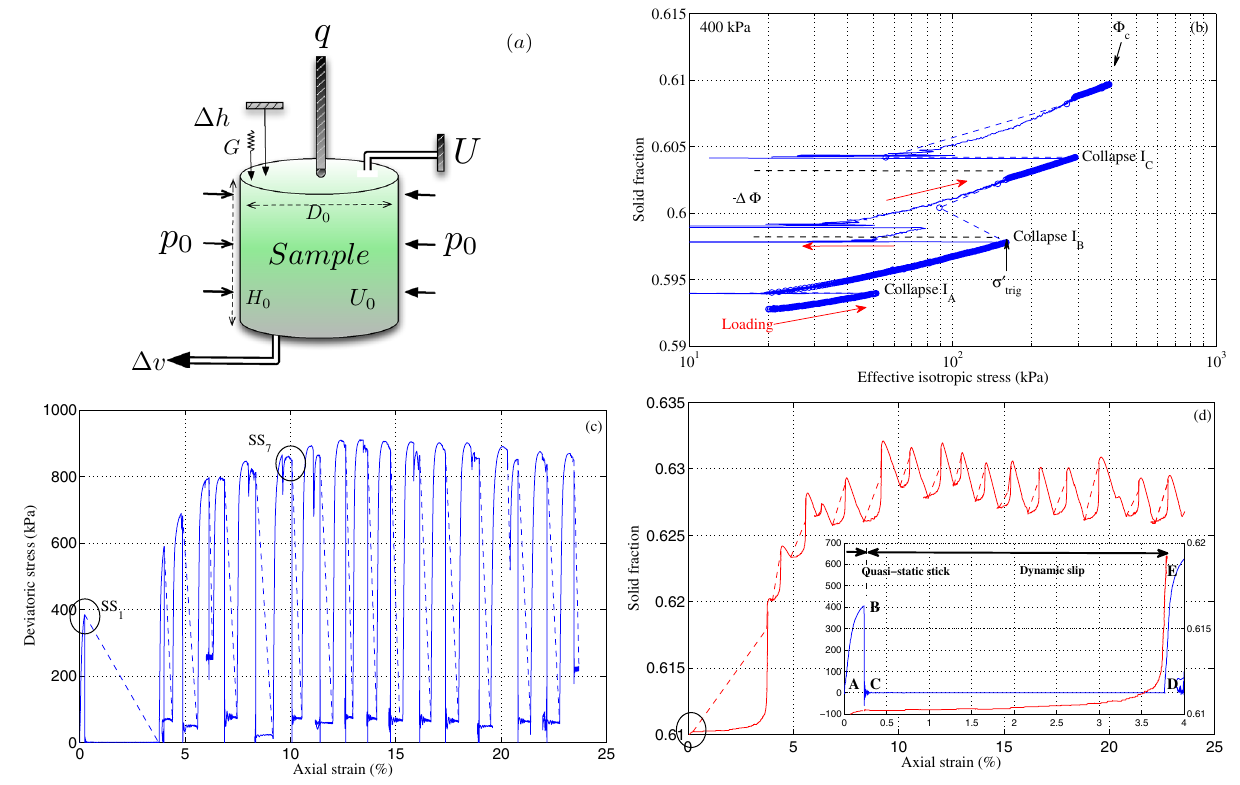
Figure 1. Dynamic instabilities of model granular materials in triaxial compression. ( a ) Sketch of the experimental setup of drained isotropic and triaxial compression on a cylindrical sample inside a triaxial cell under constant radial stress p 0 . The axial displacement (cid:31) h and the water volume (cid:31) v were measured to estimate the global axial strain ε a and solid fraction (cid:31) . The constant back pressure U 0 was applied at the sample bottom, while the measurement of static top pore-water pressure U at the sample top allowed us to assess the homogeneity of the effective stress state. One complementary piezoelectric accelerometer G measures the vertical acceleration of the sample top cap. ( b ) Collapses in isotropic drained compression from 20 up to 400 kPa. The red arrows denote the direction of loading. The dashed blue lines represent the usual response with a low sampling rate. A semilogarithmic scale is used to emphasize the low range of stress. (cid:31) c is the uncontrolled solid fraction at the end of this isotropic compression. ( c ) Realistic stress–strain behavior of the stick-slip experiment under compression at a constant confining stress of 400 kPa and a constant axial displacement rate of 0.1 mm/min, showing a large deviatoric stress drop. ( d ) Coupling solid fraction with stick-slip-like behavior. Realistic stress–strain and solid fraction behaviors of the first stick-slip event SS 1 in the inset. Only two points, B and D, are accessible using conventional laboratory equipment with a low sampling frequency. (Fig. S4 for additional